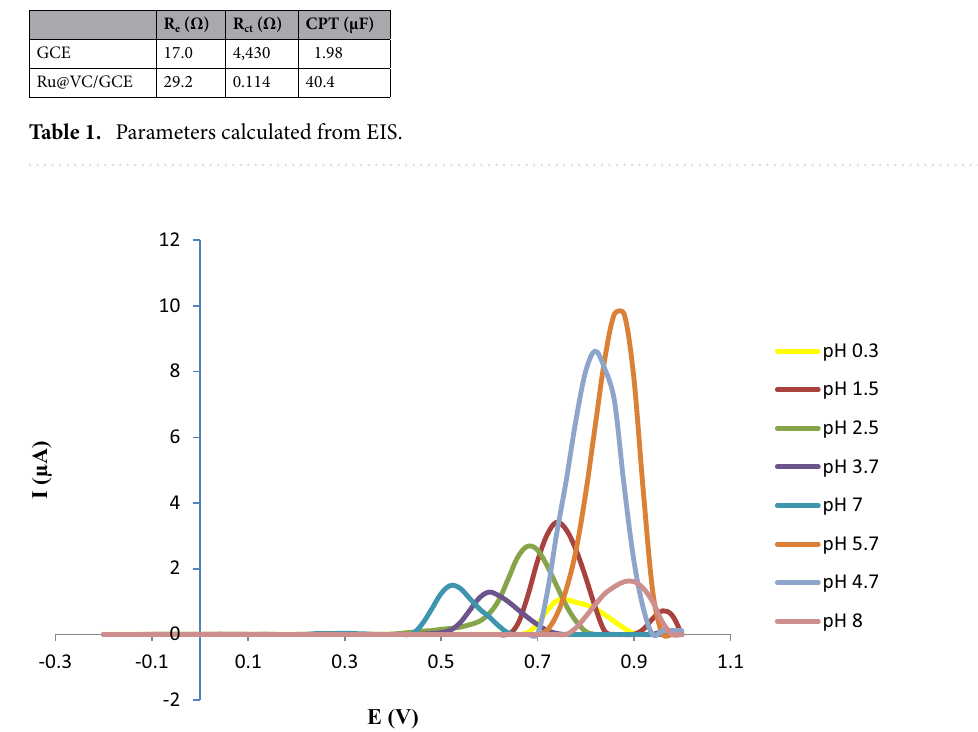
Figure 5. Differential pulse voltammetric responses of Ru@VC/GCE at different pH with scan rate 50 mV s −1